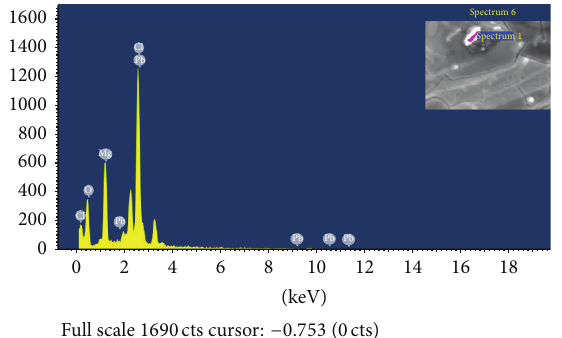
Figure 6: EDS analysis for elemental composition of lead on cell surface of isolate B. subtilis NSPA13. ∗ Inset-bacterial cell surface selected for EDS